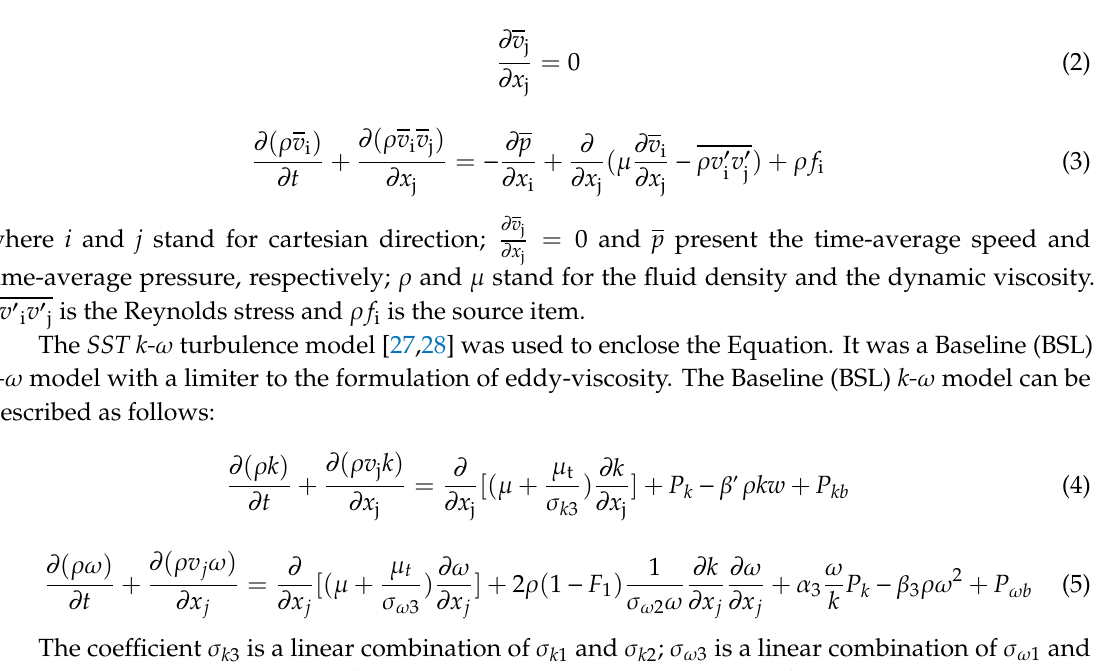
Figure 3. Grid independence of pump device without root clearance.